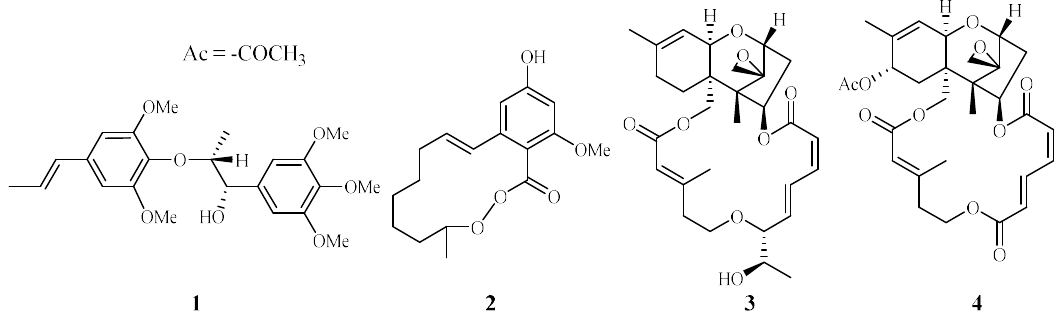
Figure 2. Compounds from R. decursiva and F. fitulosa .